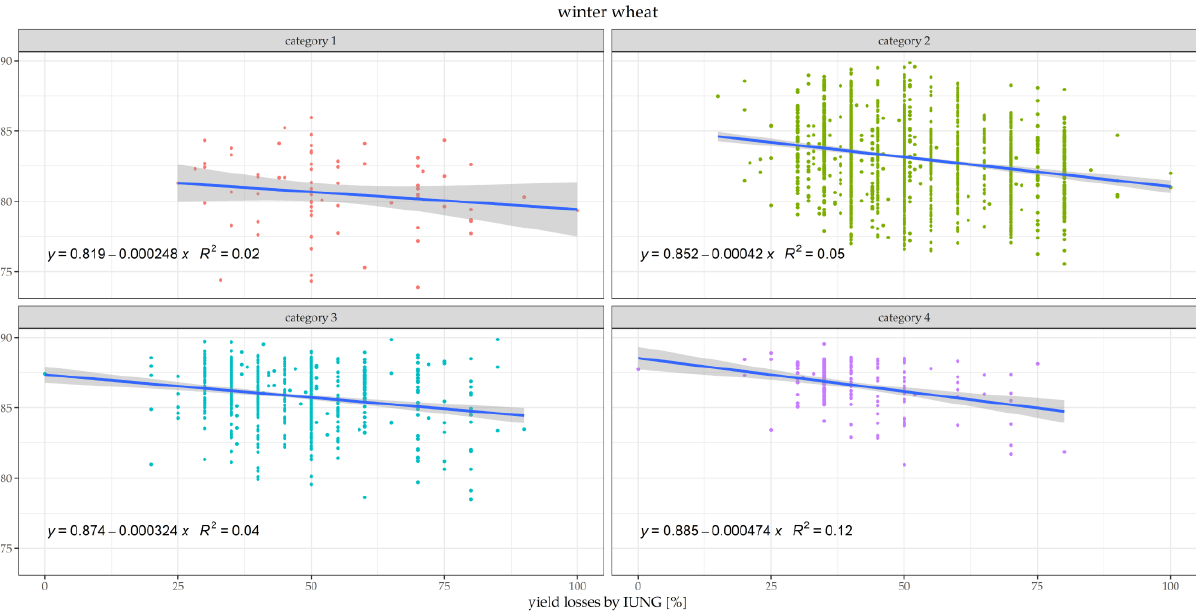
Figure 7. Regression between NDVI values and Farmers’ declarations. Source: own study (IUNG - PIB).